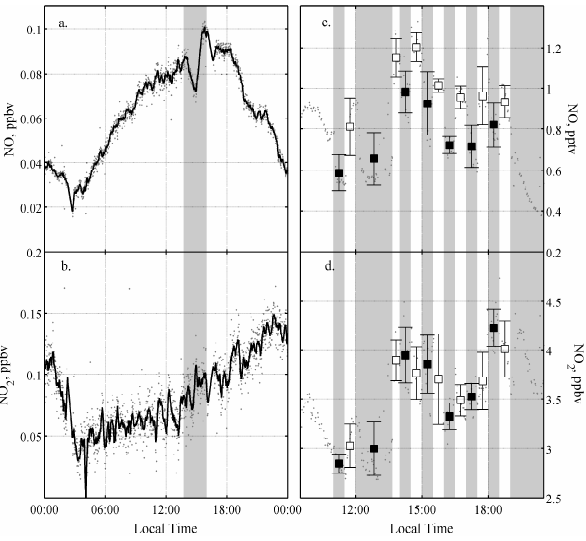
Figure 4. The impact of rapid changes in incident solar radiation on atmospheric NO x mixing ratios (1min values). (a–b) Ambient concentrations at 1m during a partial solar eclipse on 25 Novem- ber 2011 (shaded area), with black lines representing the 10min Figure 3. Firn air mixing ratios of (a) NO x and (b) O 3 , observed running mean. (c–d) Firn air concentrations at 10cm depth during on 12 January 2012. Symbols represent 30min averages. Solid and a shading experiment using UV filters on 11 January 2012. Square dashed lines are results from 20m and 50m long intake lines, re- symbols and error bars represent interval averages and standard de- spectively. Shown are also NO − concentrations in snow at 100m viation, respectively. Shaded areas and filled squares indicate time 3 (P1) and 5km (P2) distance from the lab shelter as well as from periods when the UV filter was in under the firn probe (P3).